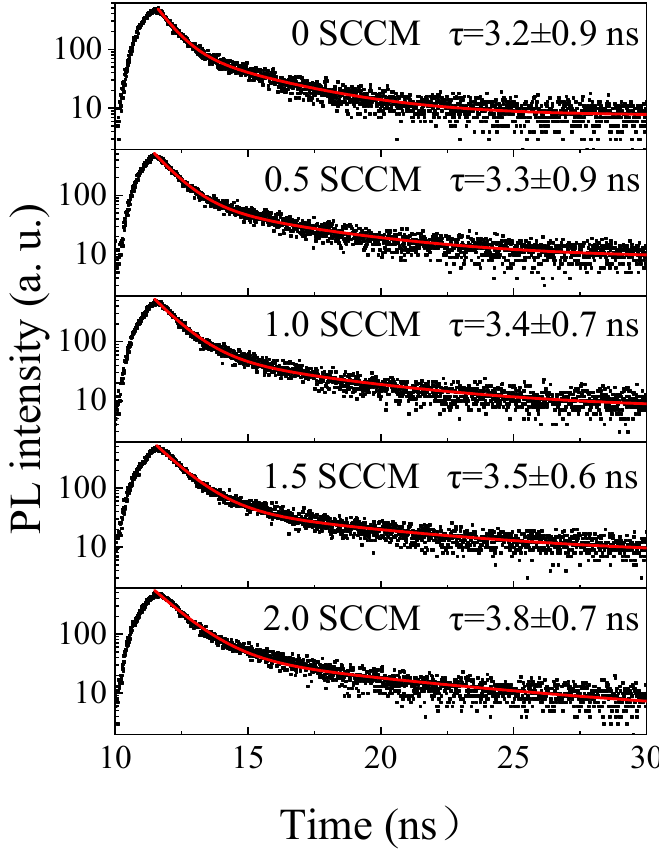
Figure 5. PL decay traces of the films prepared at different NH 3 flow rates.